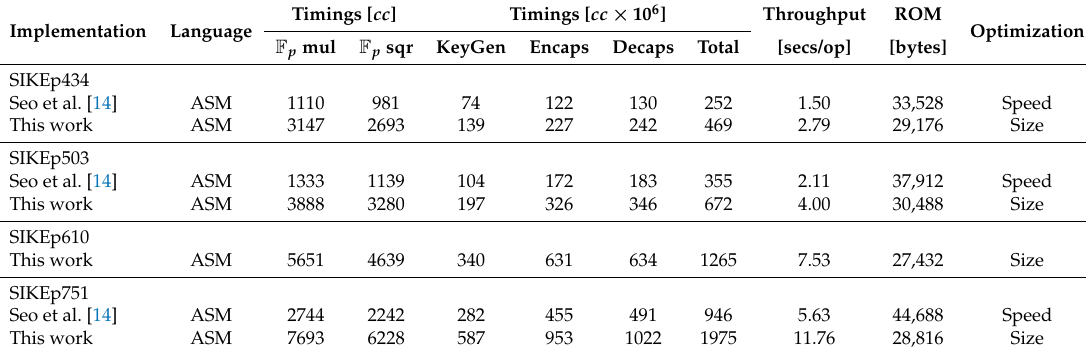
Table 3. Comparison of SIKE round 2 schemes on ARM Cortex-M4 microcontrollers. Timings are measured in clock cycles. Code size is reported in terms of bytes. Throughput is reported in terms of seconds per operation at 168 MHz.